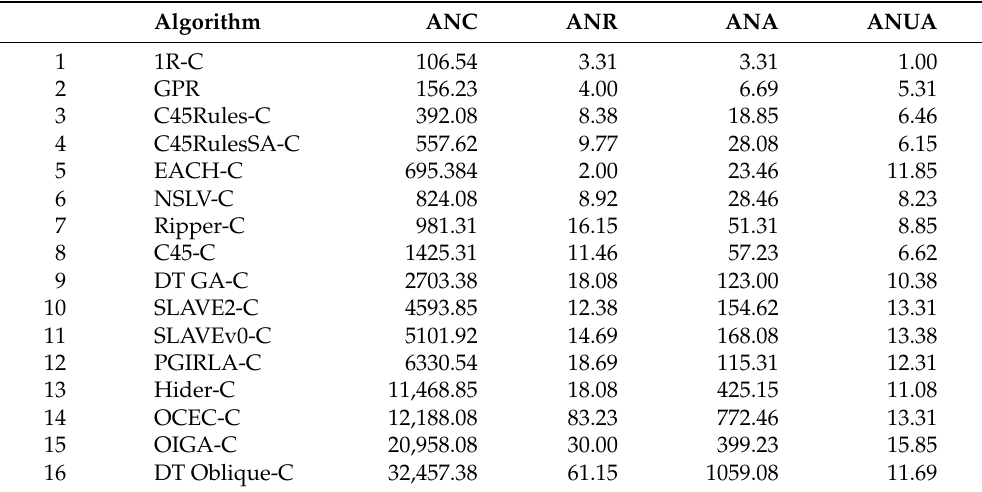
Table 3. Comparison of fuzzy rule-based classifiers in terms of rules’ size metrics.